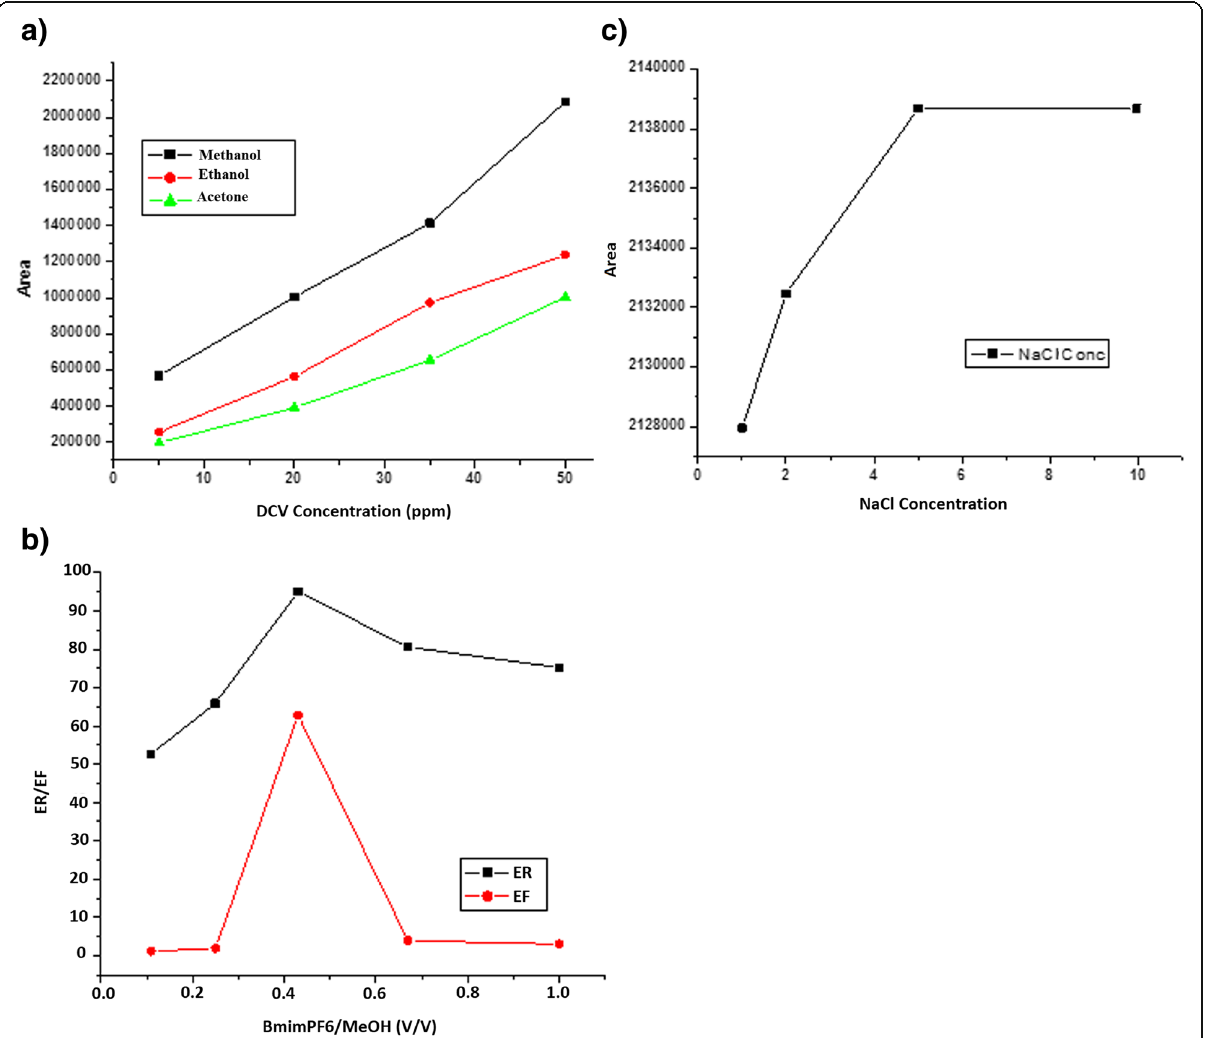
Fig. 3 Effects of various parameters a dispersive solvents, b BmimPF6: ACN ratio, and c % NaCl on the extraction of